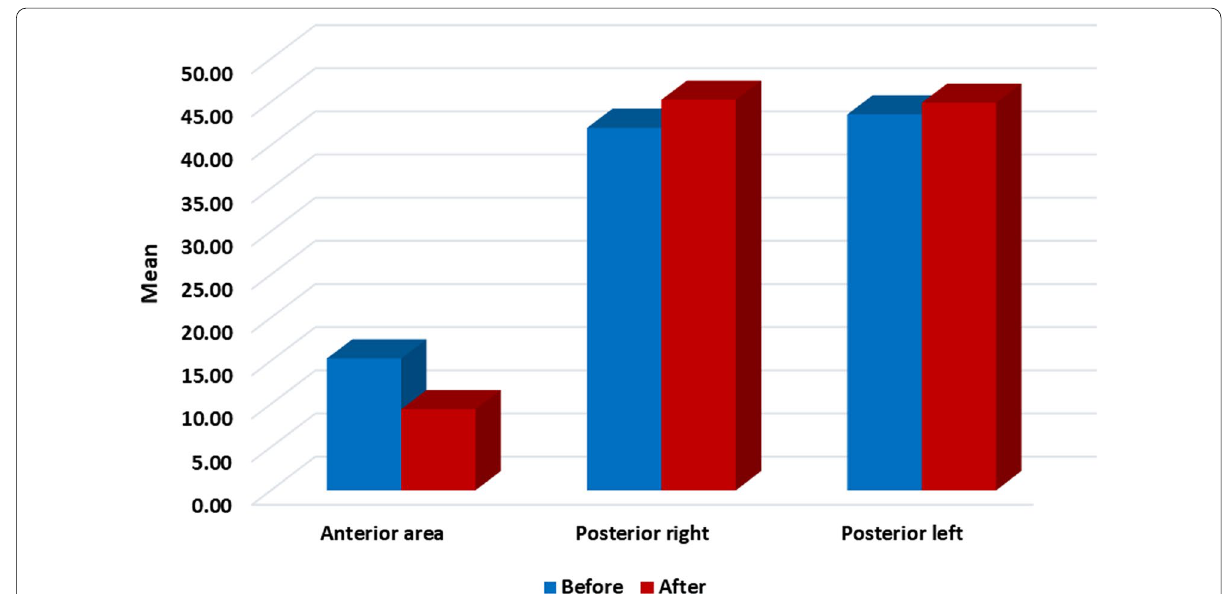
Fig. 5 Bar chart represents occlusal forces percentages before and after denture relining in all study